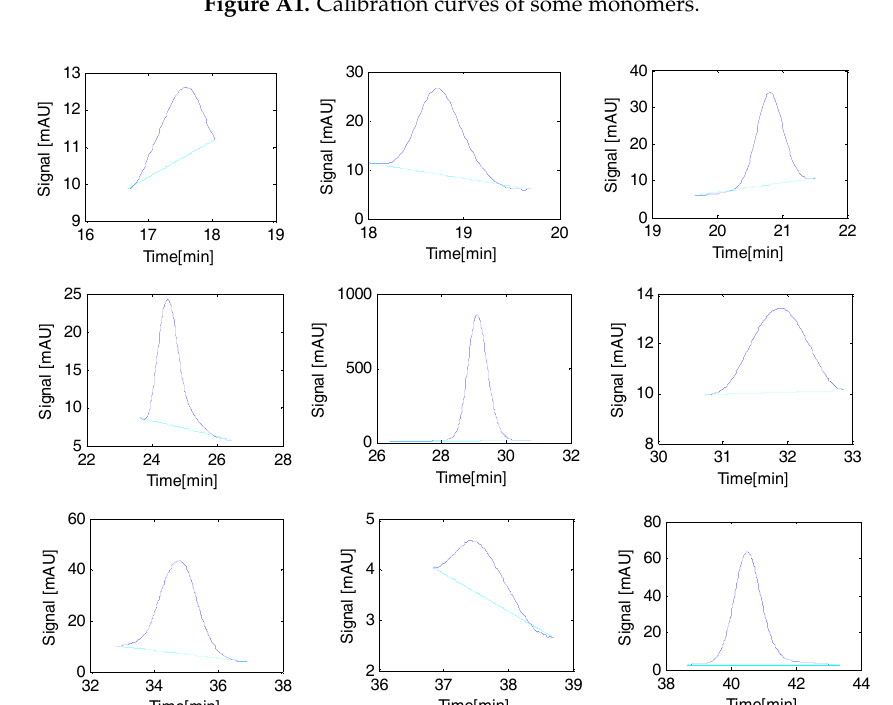
Figure A2. Example of peak identification and base-line determination for integration (peaks are in blue color and base lines are in cyan color).